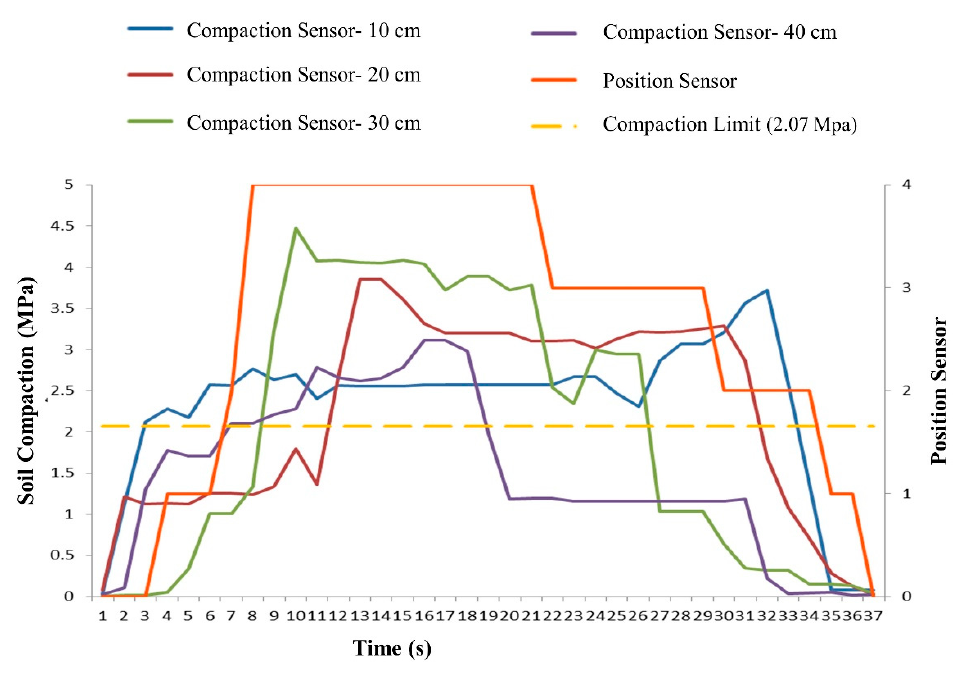
Figure 11. Combinational performance of compression sensors (depths of 10, 20, 30, and 40 cm), limit density (2.07 MPa), and the location of the subsoiler position sensor.